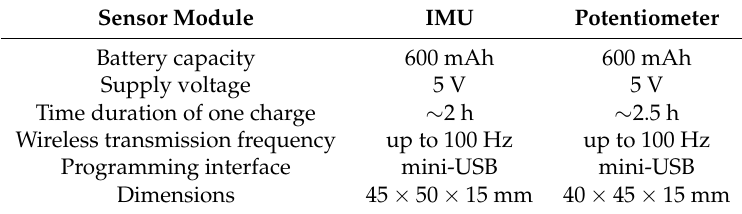
Figure 5. Assembled modules of the final arm motion-tracking system: ( a ) IMU sensor; ( b ) potentiometer; ( c ) data receiver; ( d ) battery charger. Table 1. Specifications of the Arm Motion-Tracking System Sensor